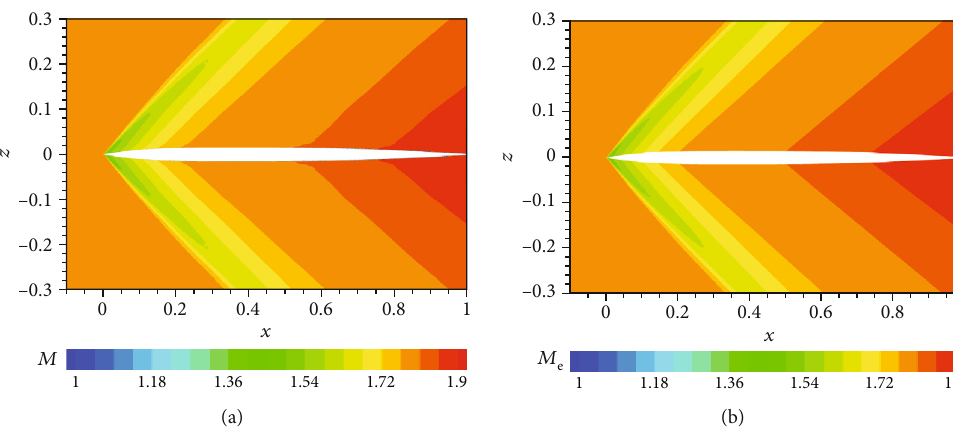
Figure 14: Comparison between (a) local Mach number and (b) predicted M